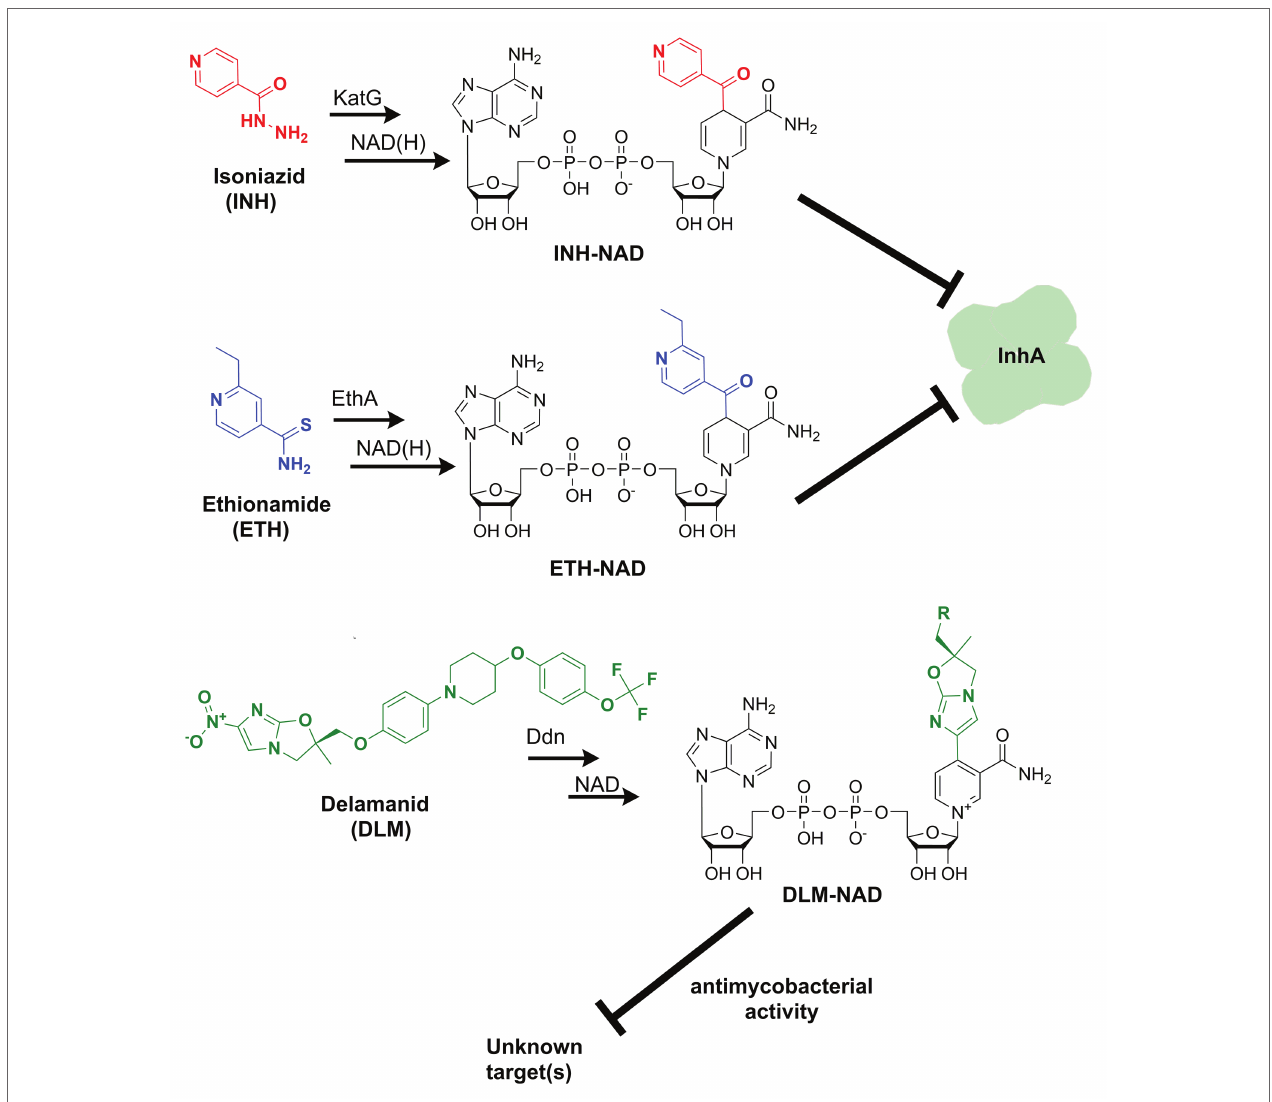
FIGURE 1 | Formation of nicotinamide adenine dinucleotide (NAD) chemical adducts by tuberculosis (TB) drugs. Prothionamide, a close chemical analog of ethionamide, undergoes the same transformation. Pretomanid, belonging to the same class of nitroimidazoles as delamanid, may combine with NAD as well. Their structures have been omitted for